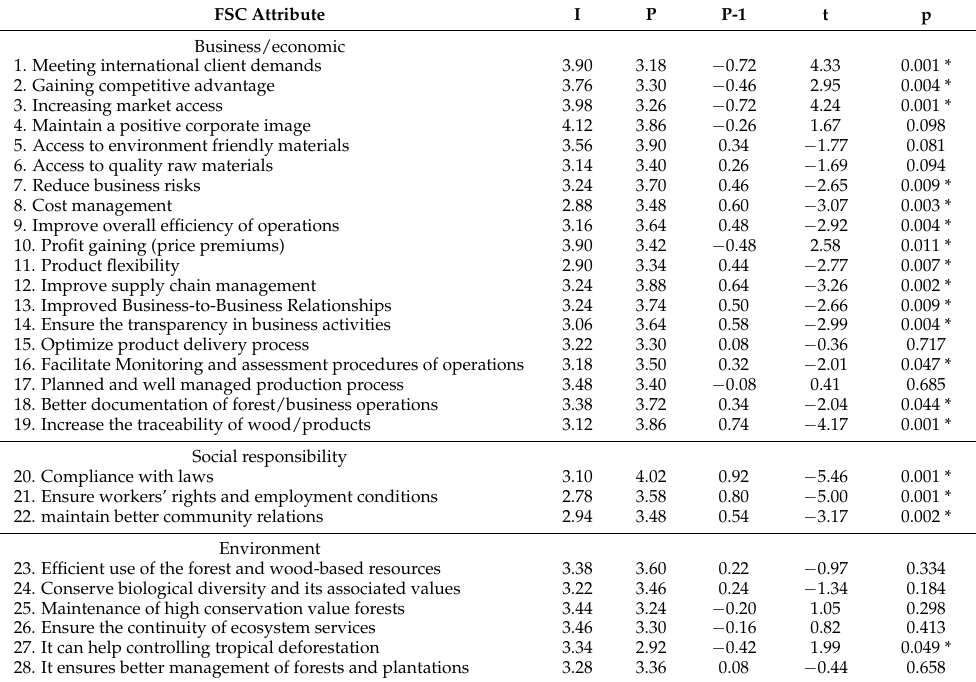
Table 3. Mean levels of importance (I) and performance (P) and the gap (P—I) with selected attributes of FSC certification.